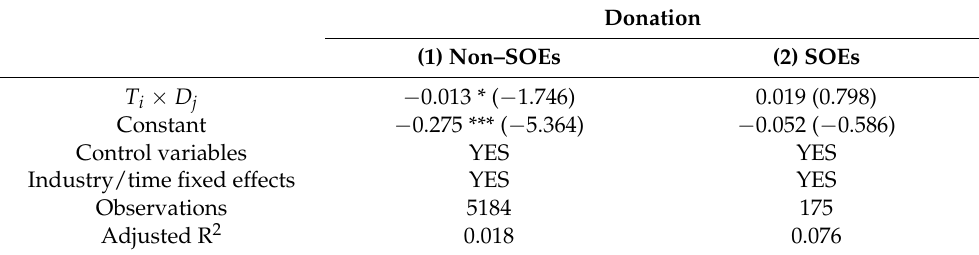
Table 8. Results of the effect of differences in the nature of